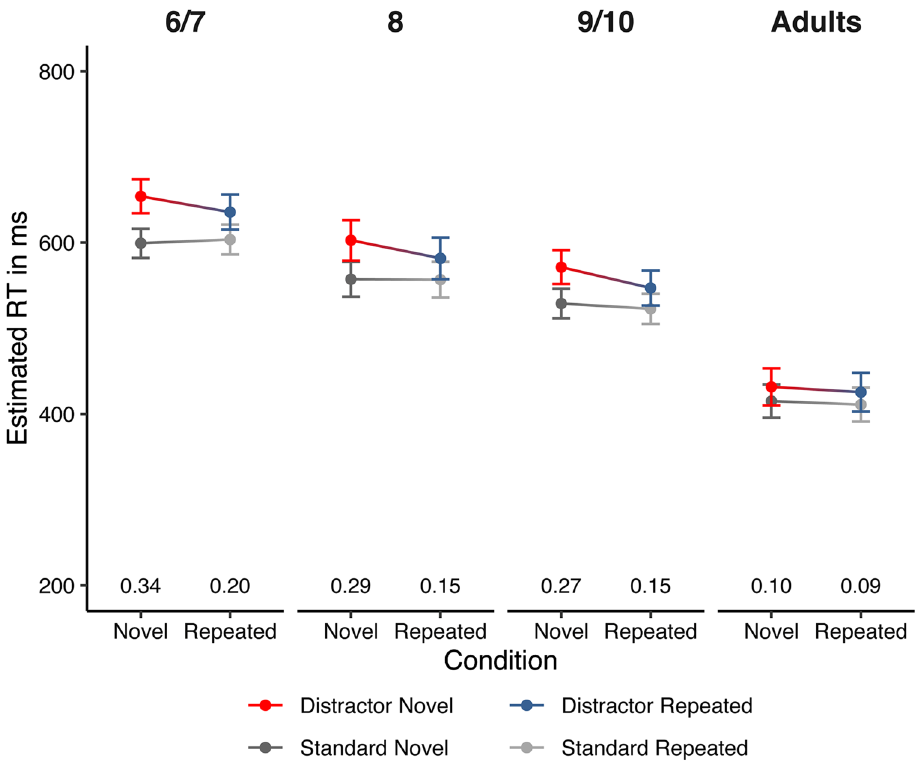
Figure 2. Model-implied response times as a function of sound, condition and age group. The error bars represent 95% confidence intervals. The numbers at the bottom are standardized distraction effects (i.e., (cid:31) RT (cid:31) RT distractor − standard for z -standardized RTs).